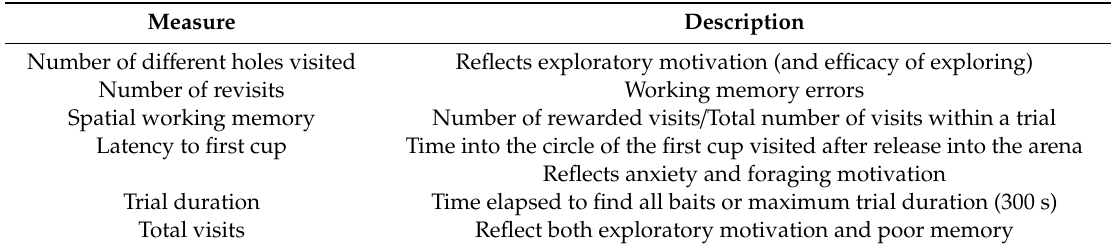
Table 1. The measurements recorded in the holeboard trials (Adapted from van der Staay et al.